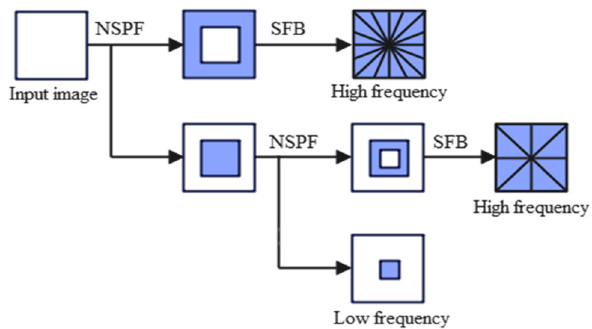
Fig. 1 Two-level NSST